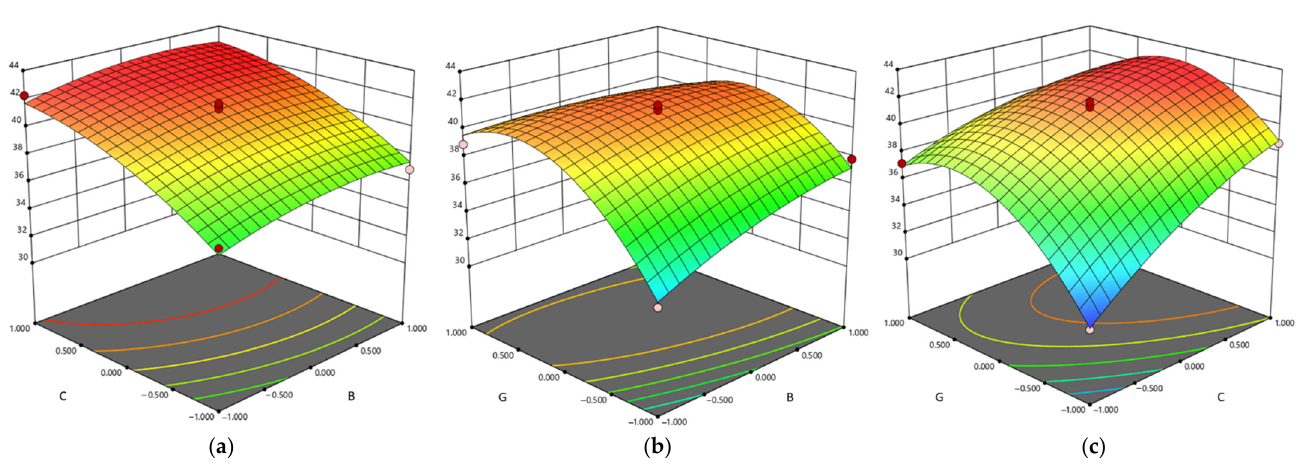
Figure 5. Box–Behnken test results response surface. ( a ) Effect of powder–powder static friction coefficient and rolling friction coefficient on resting angle of powder; ( b ) effect of powder–powder static friction coefficient and JKR surface energy on powder resting angle; ( c ) effect of powder–powder static friction coefficient and JKR surface energy on powder resting angle.